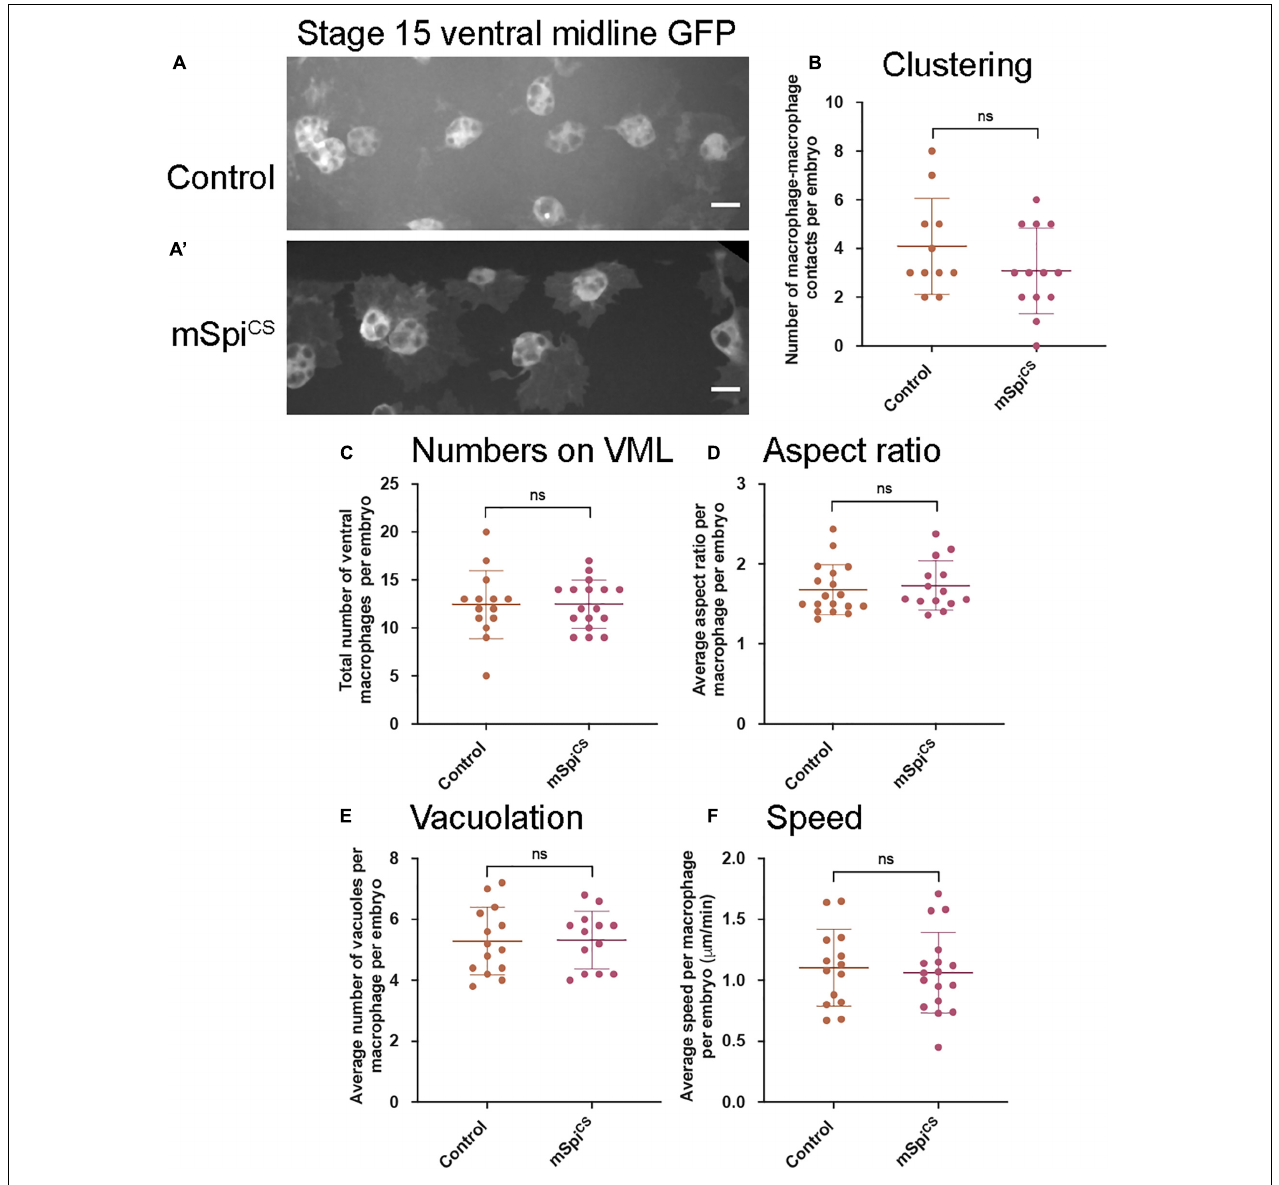
FIGURE 2 | Expression of a membrane-bound form of Spitz fails to induce changes in embryonic macrophage behavior. (A,A (cid:48) ) Representative images of GFP-labeled macrophages in control embryos (A) and embryos containing macrophages expressing mSpi CS -GFP (A (cid:48) ) on the ventral midline at stage 15; mSpi CS -GFP macrophages appear more defined due to additional GFP expression due to the GFP tag that is part of the mSpi CS -GFP transgene; scale bars represent 10 µ m. (B–F) Scattergraphs showing number of macrophage-macrophage contacts per embryo to assay macrophage clustering (B) ( n = 11, 13; p = 0.690), numbers of macrophages on the ventral midline (C) ( n = 14, 17; p = 0.188), cell body aspect ratio per macrophage, per embryo (D) ( n = 18, 14; p = 0.464), vacuoles per macrophage, per embryo (E) ( n = 14, 13; p = 0.926) and random migration speed in µ m per minute (F) ( n = 14, 17; p = 0.743) at stage 15 in controls and embryos with macrophage-specific expression of mSpitz CS . Lines and error bars represent mean and standard deviation on scattergraphs, respectively; significance bars denote p > 0.05 (ns); statistical comparisons made via Mann–Whitney test (D) or unpaired, two-tailed Student’s t -test (B,C,E,F) . Embryo genotypes are as follows: w; Srp-GAL4,UAS-GFP/ + ; Crq-GAL4,UAS-GFP/ +(Control), w; Srp-GAL4,UAS-GFP/ + ; Crq-GAL4,UAS-GFP/UAS-mSpitz CS -GFP (mSpi CS ).